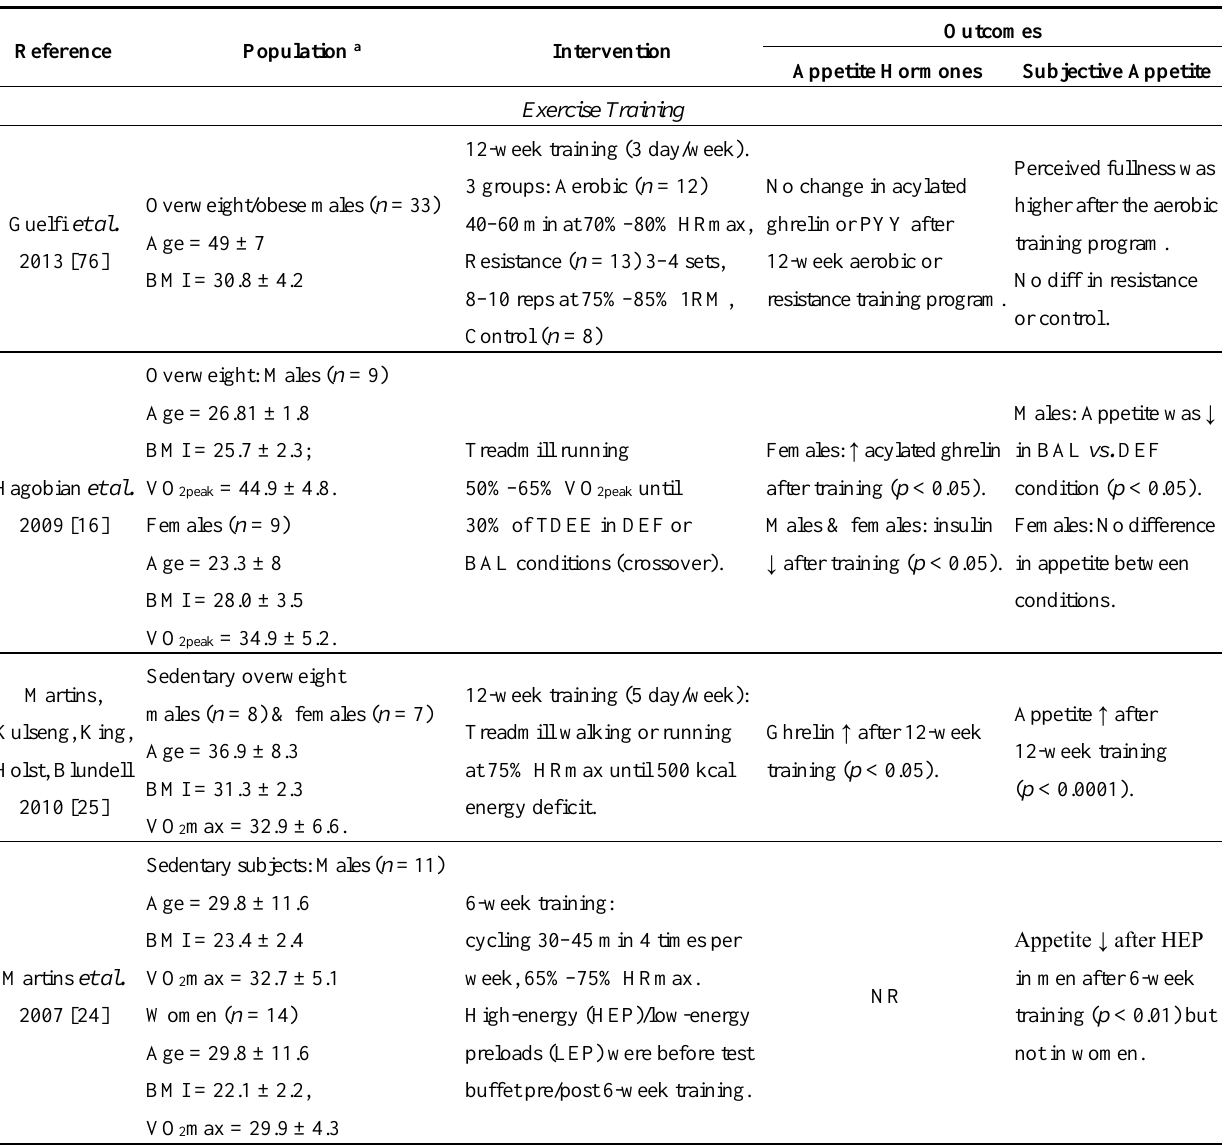
Table 3. Review of studies examining the effect of exercise training on subjective and objective appetite in sedentary and/or overweight individuals participating in an exercise-training